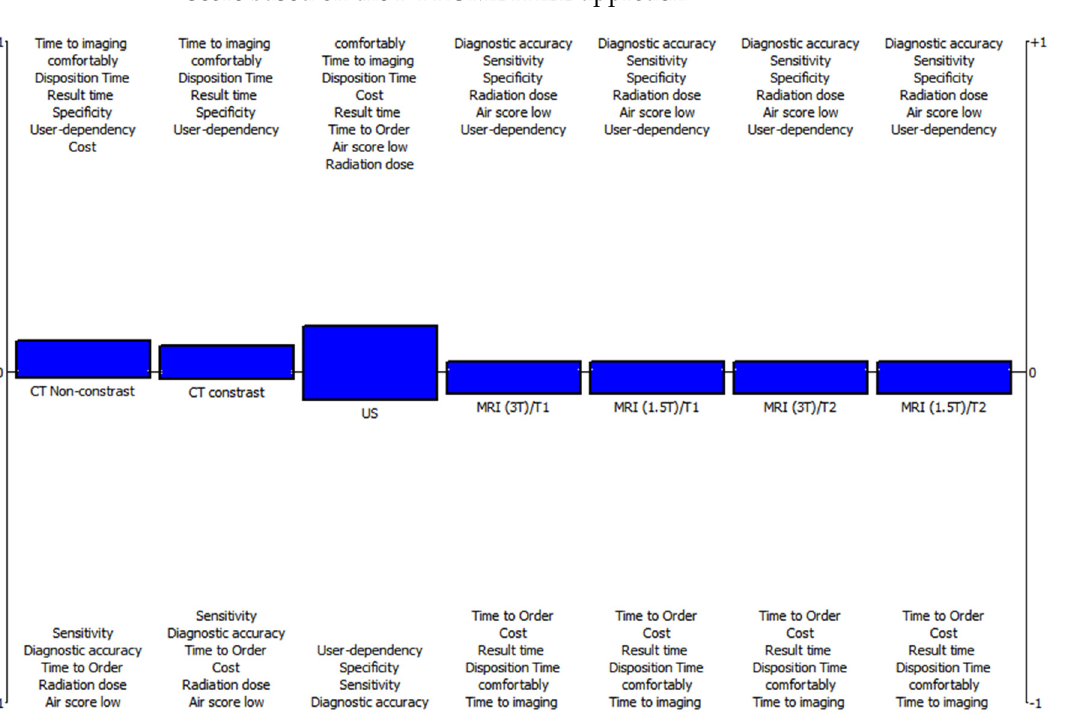
Figure 2. Evaluation of the acute appendicitis diagnosis for low AIR score with F-PROMETHEE.